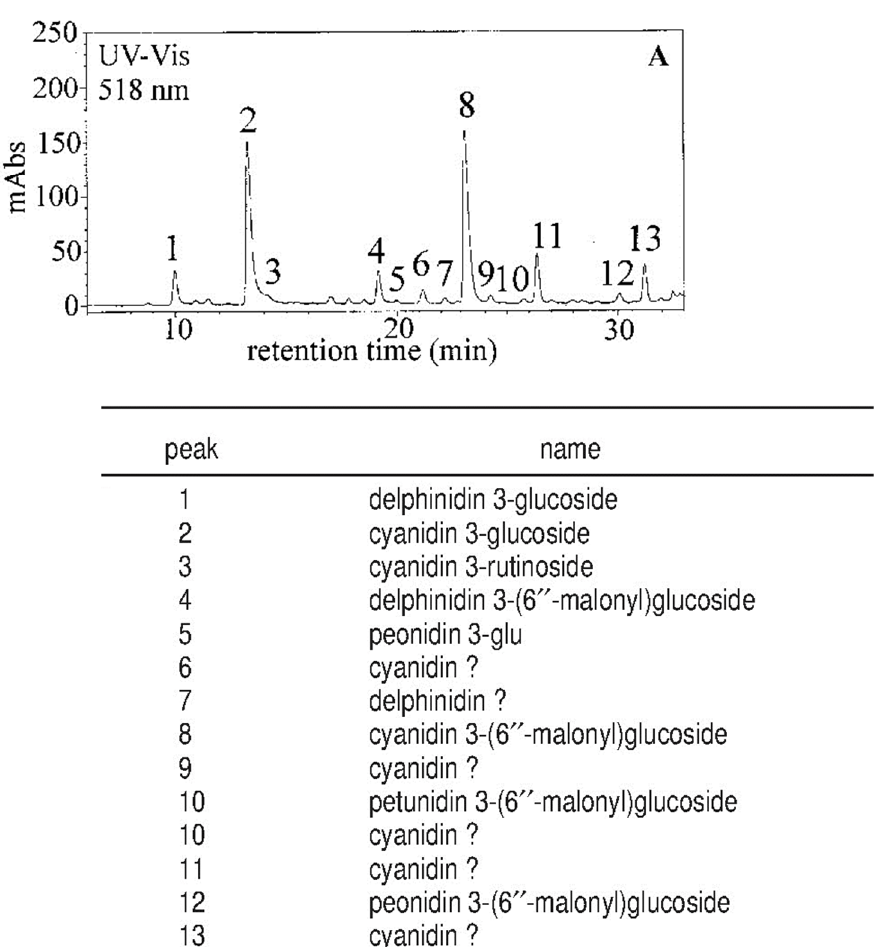
Figure 4. Micro-HPLC-UV-vis chromatogram and identified anthocyanins of ‘Moro’ orange juice. Reprinted from Dugo et al.